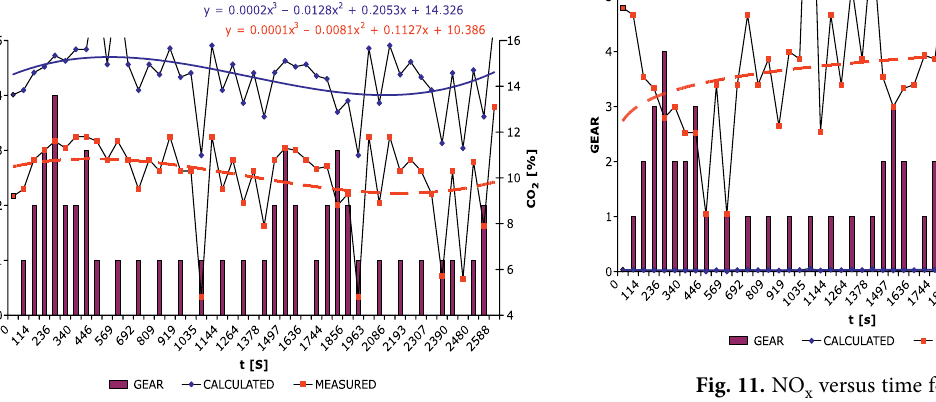
Fig. 11. NO x versus time for LPG fuel (air conditioning unit is turned off)